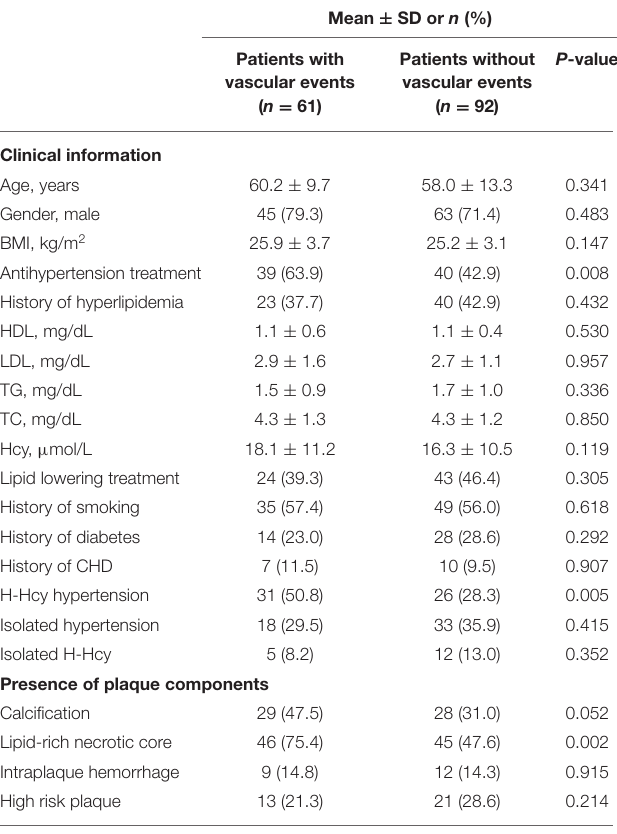
TABLE 3 | Comparison of clinical characteristics and carotid plaque features in patients with and without subsequent vascular events ( n = 153).